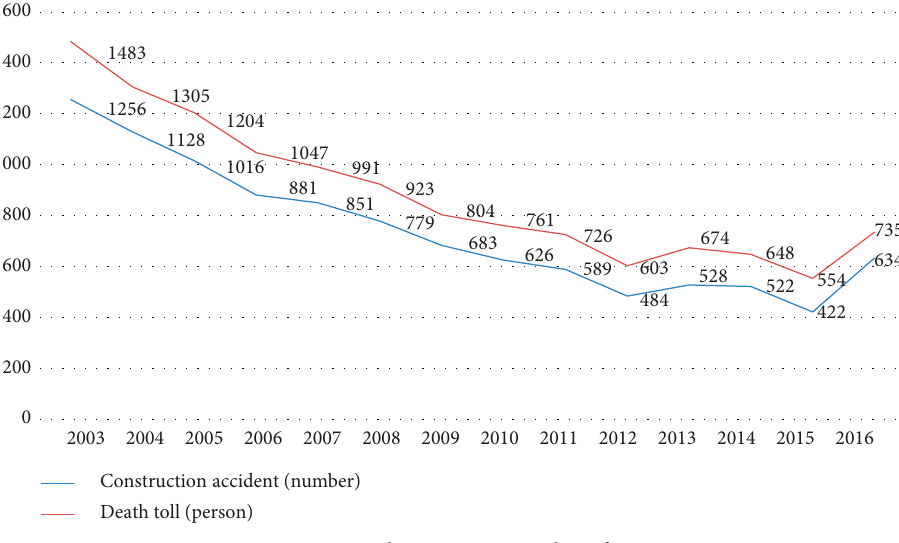
Figure 1: Construction accident statistics in China from 2003 to